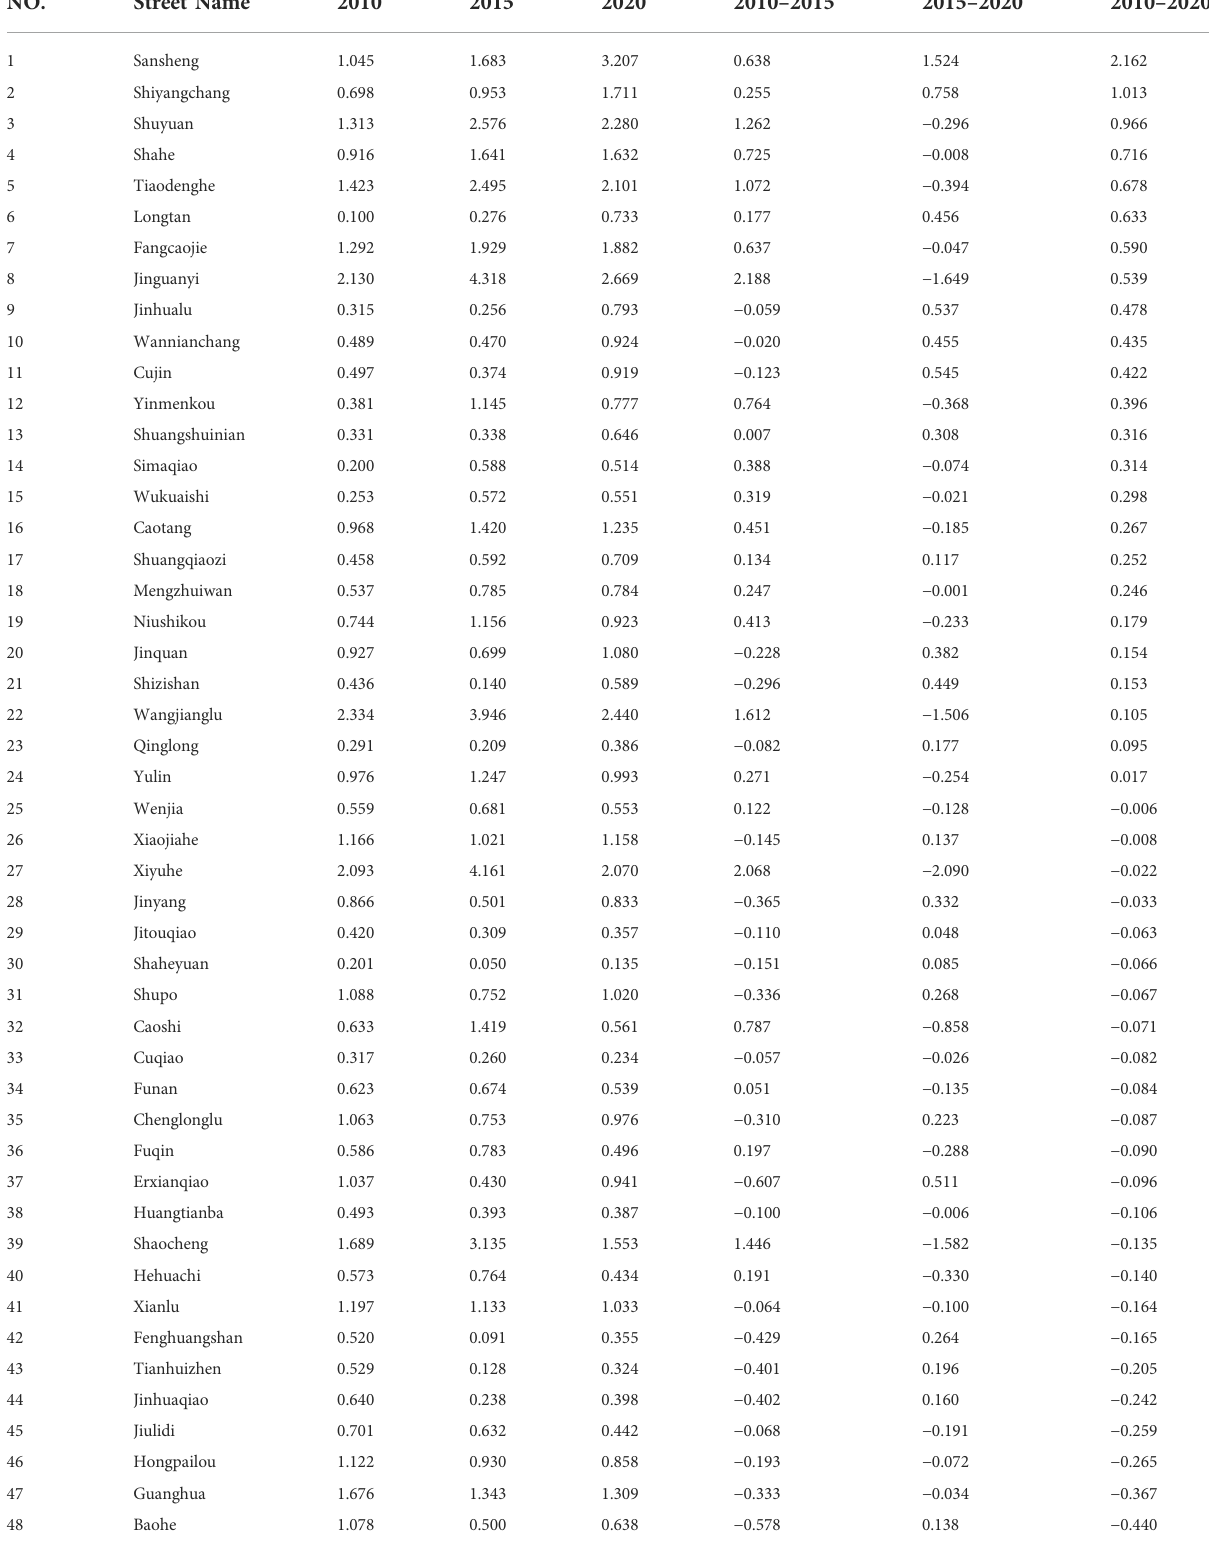
TABLE 3 The levels of commercial gentri fi cation in the Streets of Chengdu 2010 –